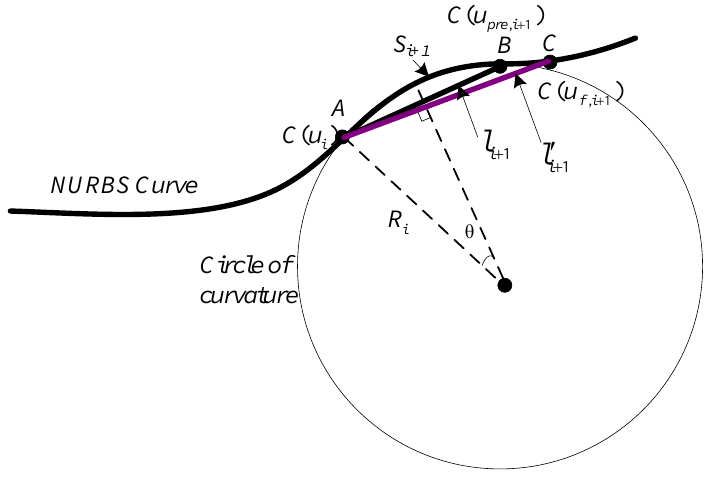
Figure 1. NURBS curve interpolation trajectory.